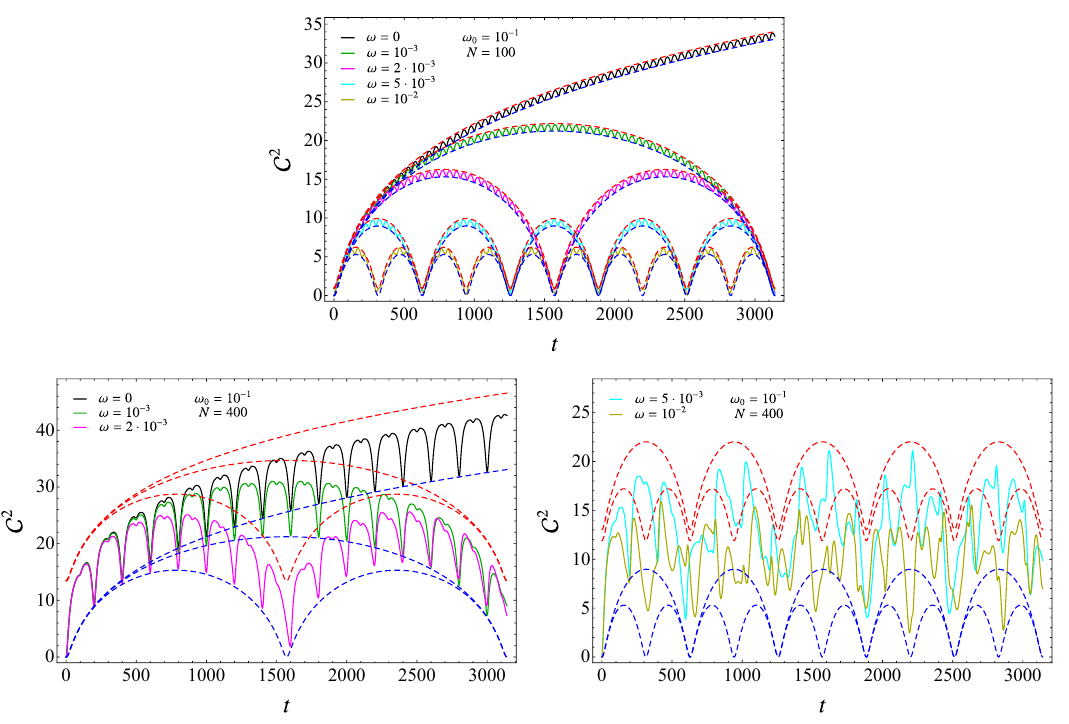
Figure 2 . Temporal evolution of the complexity (3.7) (solid lines) and of the corresponding bounds in (2.40) for PBC. The blue and red dashed lines show the lower and the upper bounds, from (2.34) and (2.39)